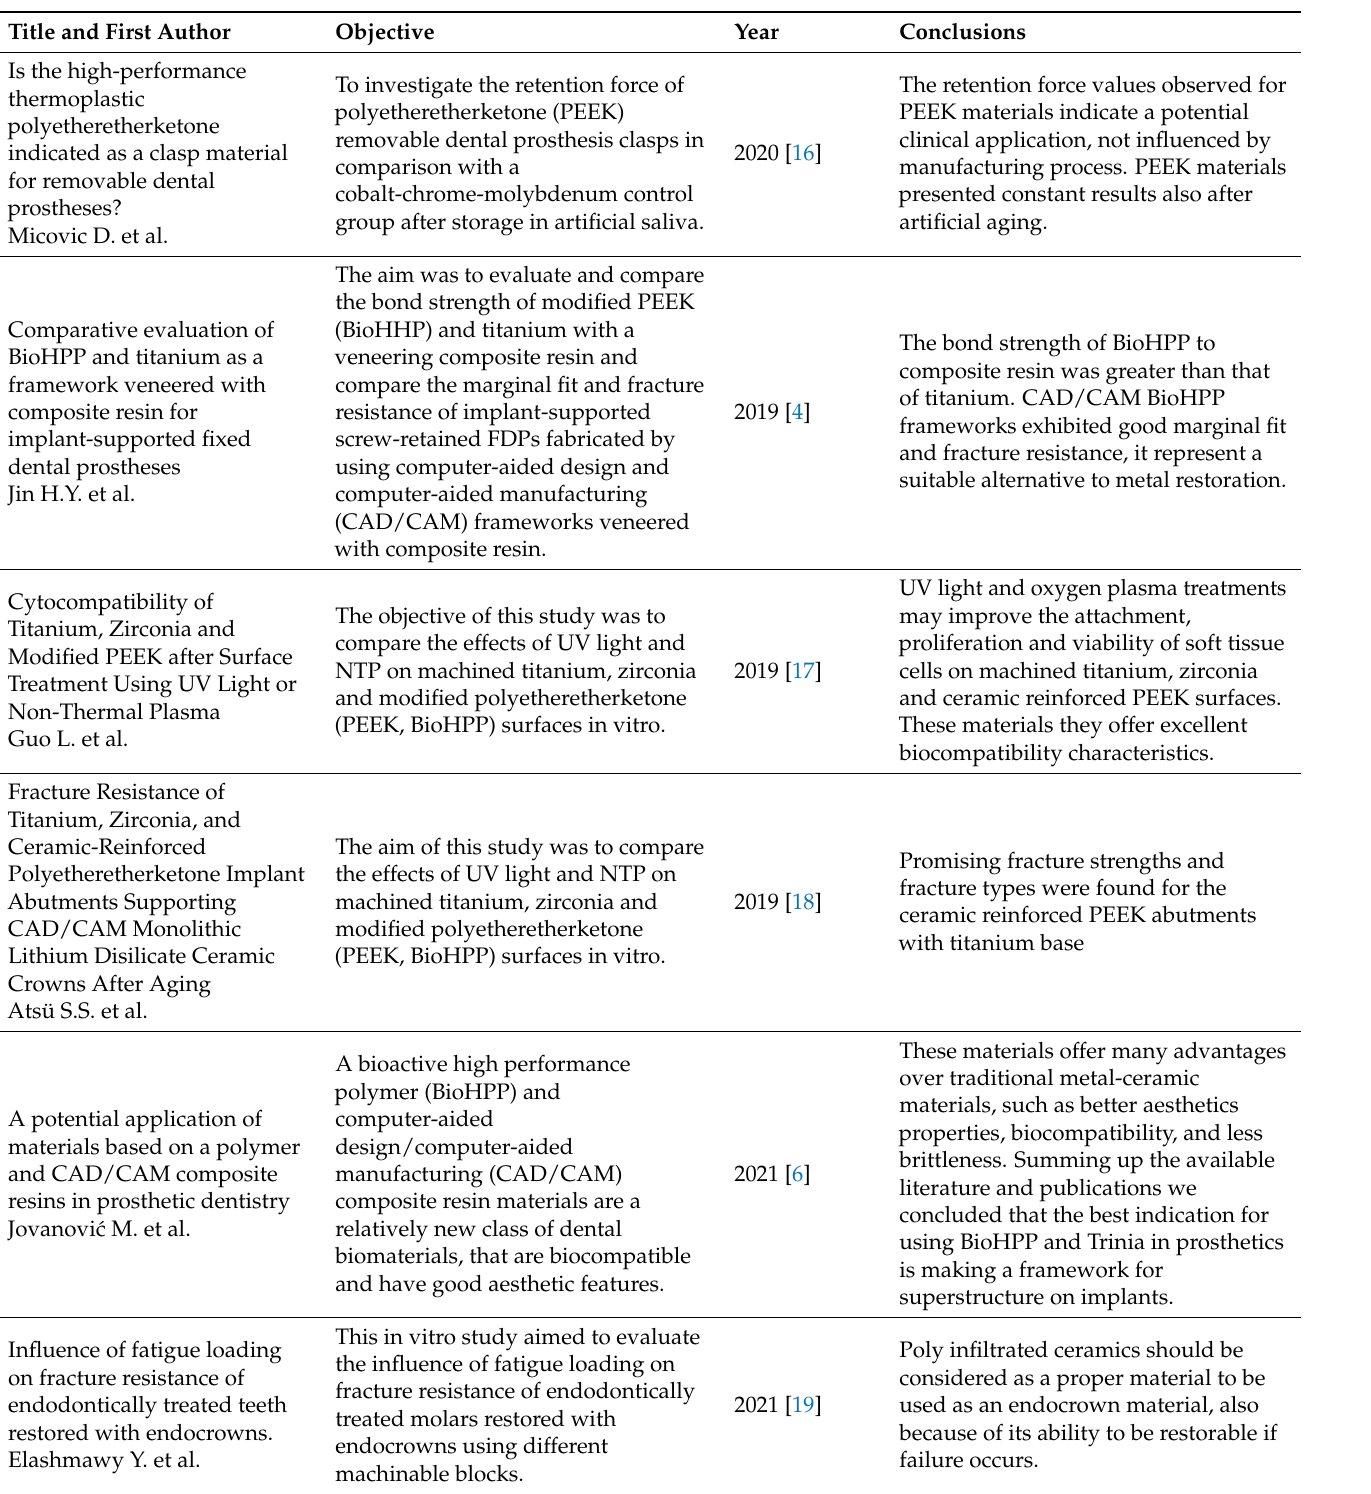
Table 1. Included studies